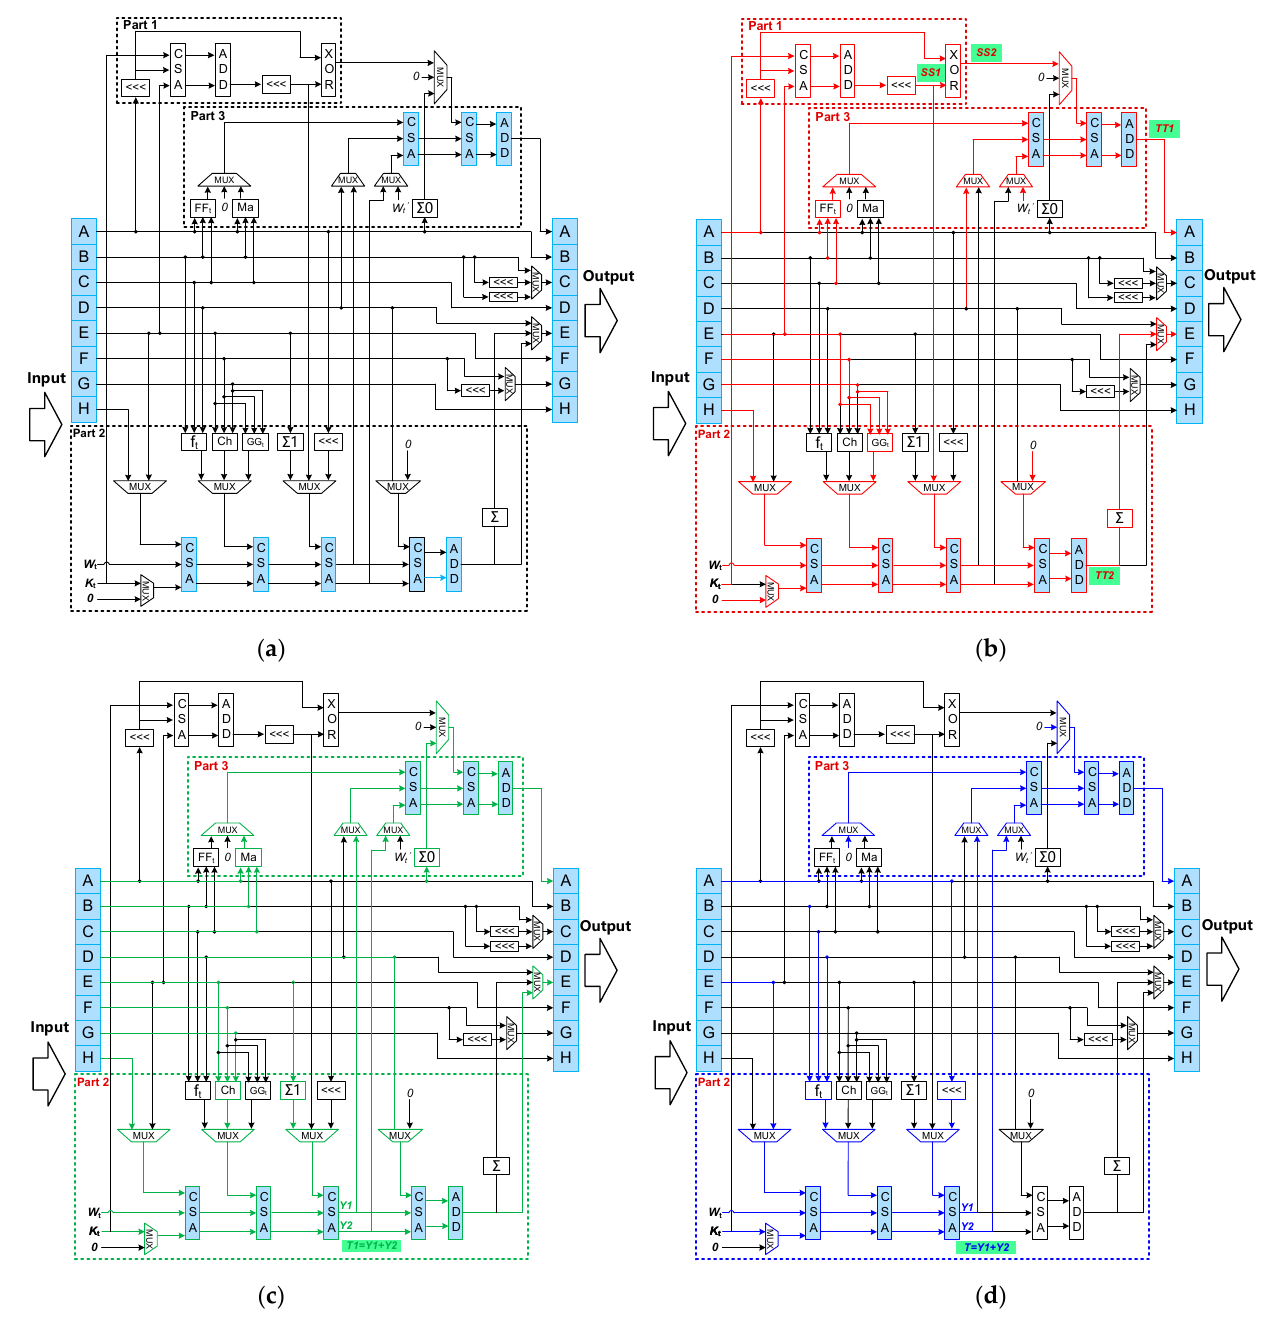
Figure 10. ( a ) Hardware architecture of the proposed reconfigurable round function iteration mod- ule in the reconfigurable hash unit, and its three operation modes for ( b ) SM3, ( c ) SHA-256 and ( d ) SHA-1, respectively.